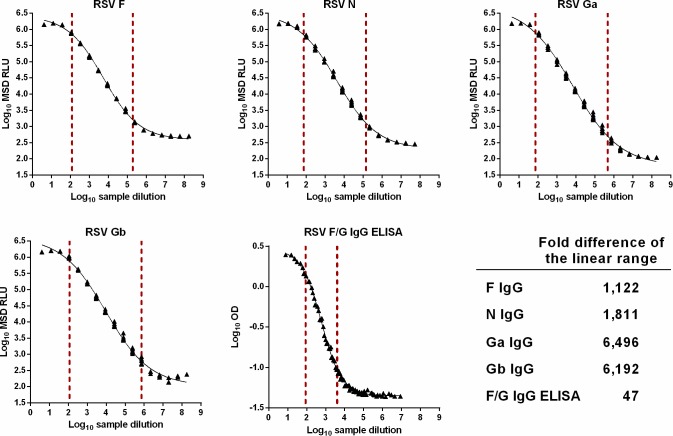
Linear range comparison between RSV ECL assays and a diagnostic RSV F/G ELISA.The assay control was used to illustrate the linear range of the four ECL assays and the diagnostic F/G ELISA. Linearity samples were prepared from the assay control and serially diluted before addition to the MSD or ELISA plates. MSD RLU or ELISA OD (optical density) values were log10-transformed and plotted versus the log10-transformed sample dilution. The upper and lower limits of the linear range were calculated using a 4-parameter logistic model and marked by dashed red lines. The fold difference was calculated for each assay as the ratio between limits of the linear range.